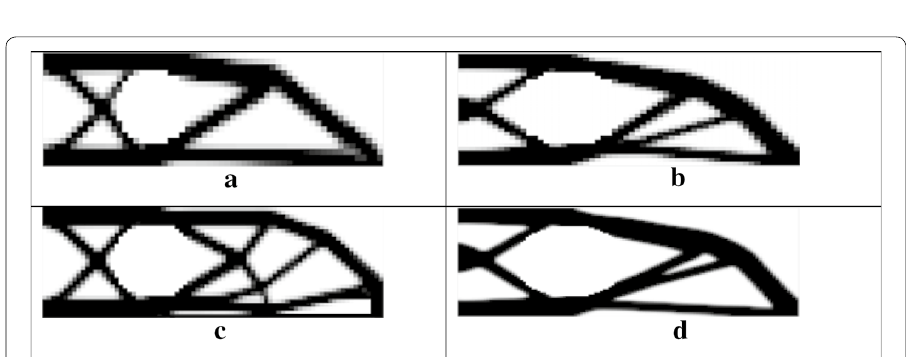
Fig. 13 Optimal material plots for numerous sizes of design domain a 40 120 ×